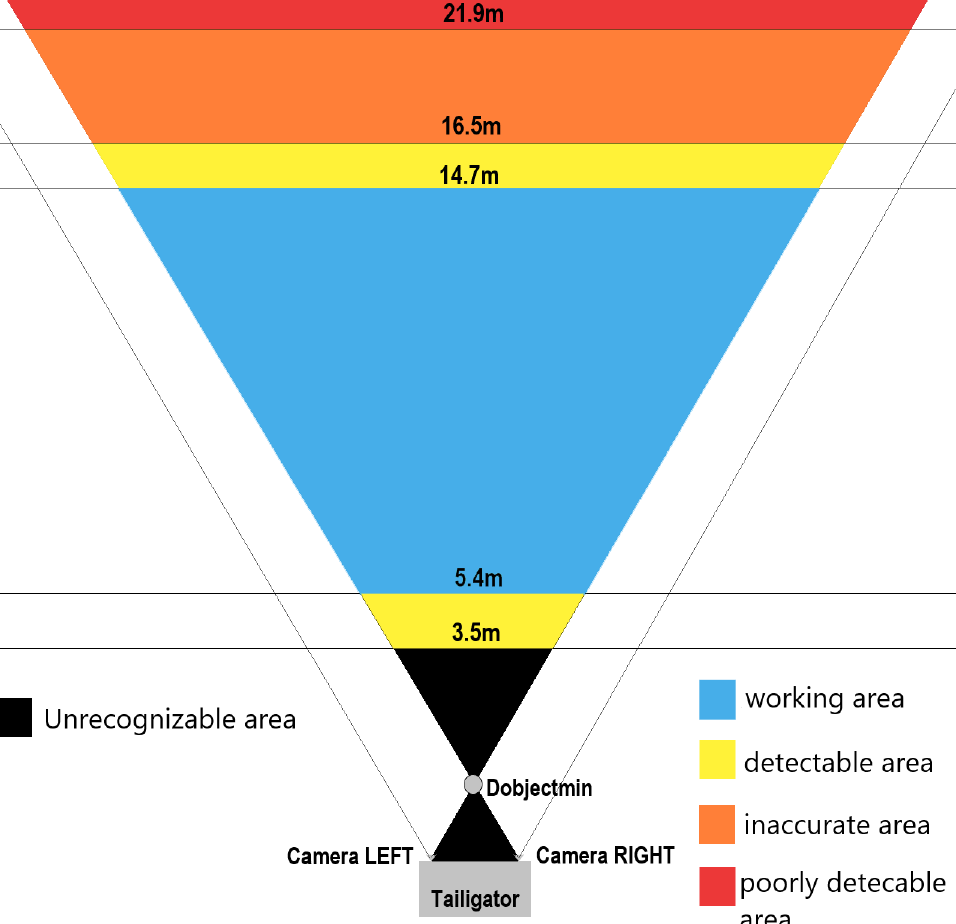
Figure 9. Working areas of the Tailigator related to the